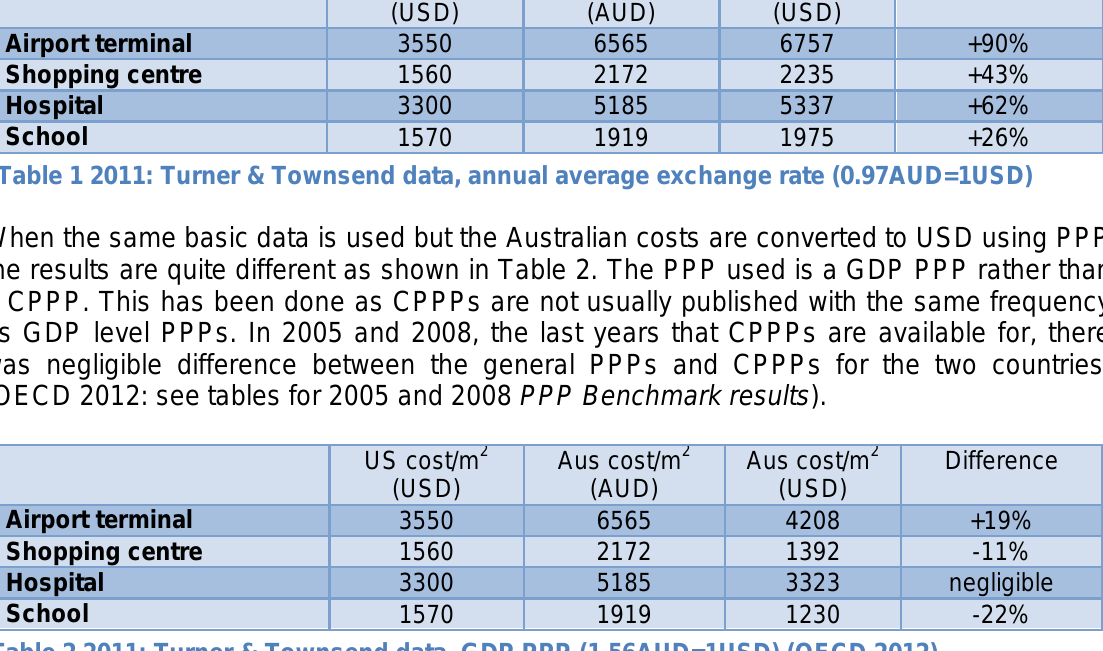
Table 2 2011: Turner & Townsend data, GDP PPP (1.56AUD=1USD) (OECD 2012)